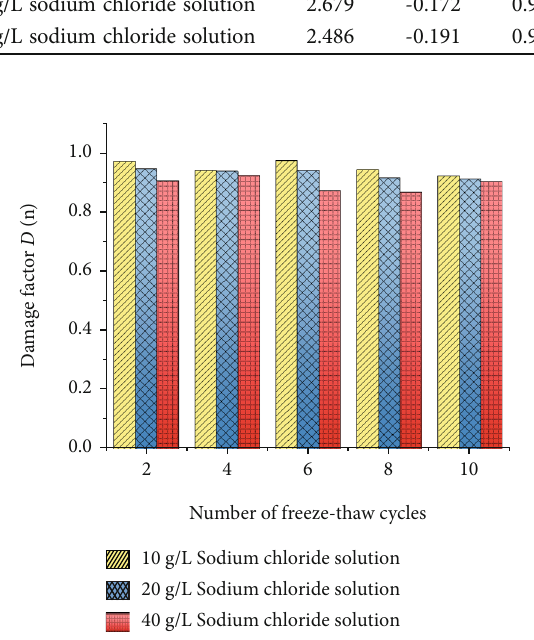
Figure 8: Relationship between sample damage and cycle times and solution concentration.